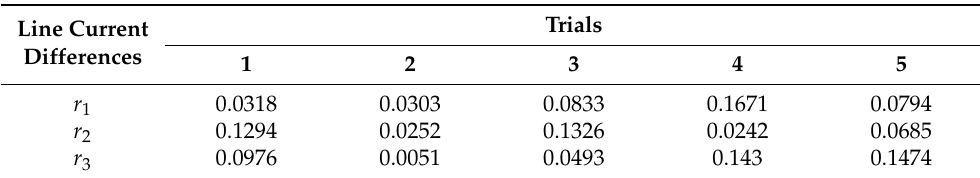
Table 3. Arithmetic differences obtained from the RMS values of the line currents from a healthy motor.